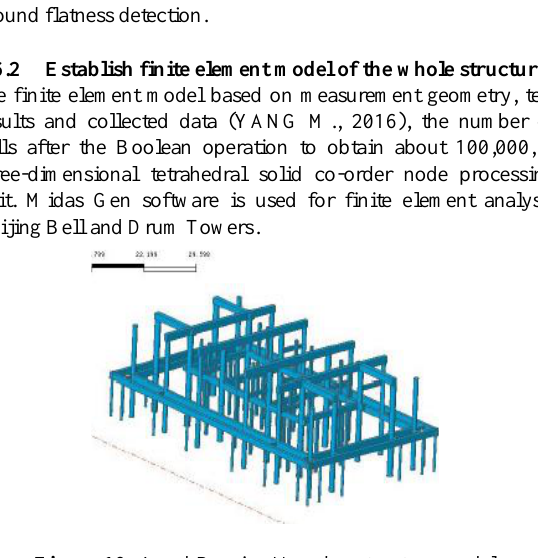
Figure 10. Load-Bearing Wooden structure